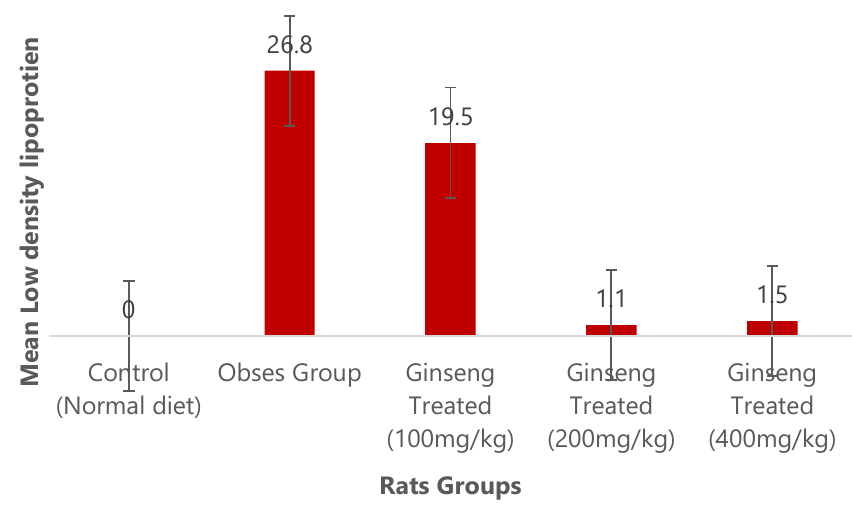
Figure 11: Comparison of mean low-density lipoprotein in different